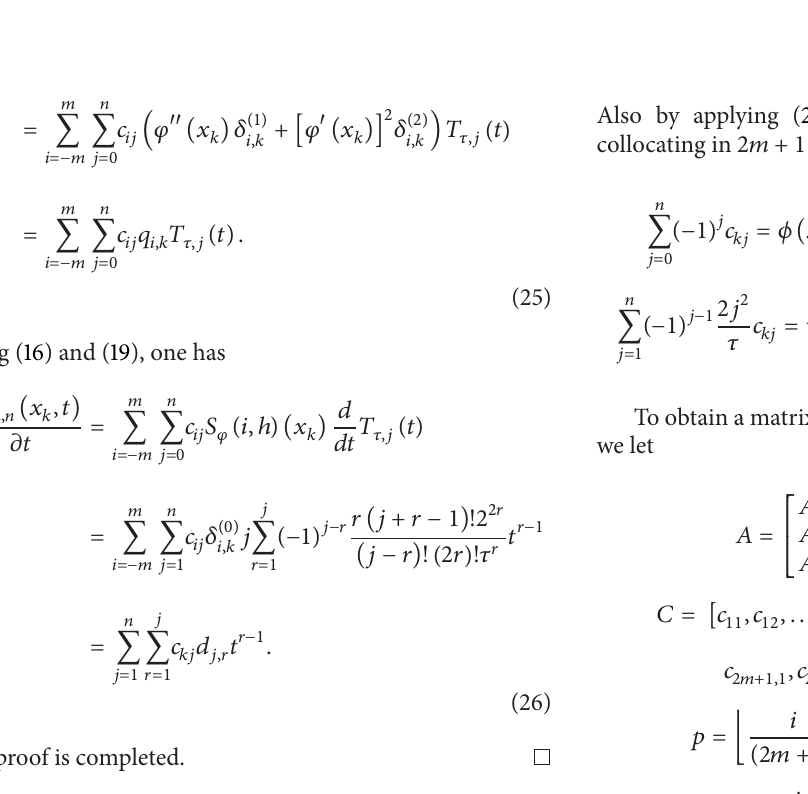
Figure 1: Comparison of the numerical and exact solution in the domain [0,1] × [0,1]